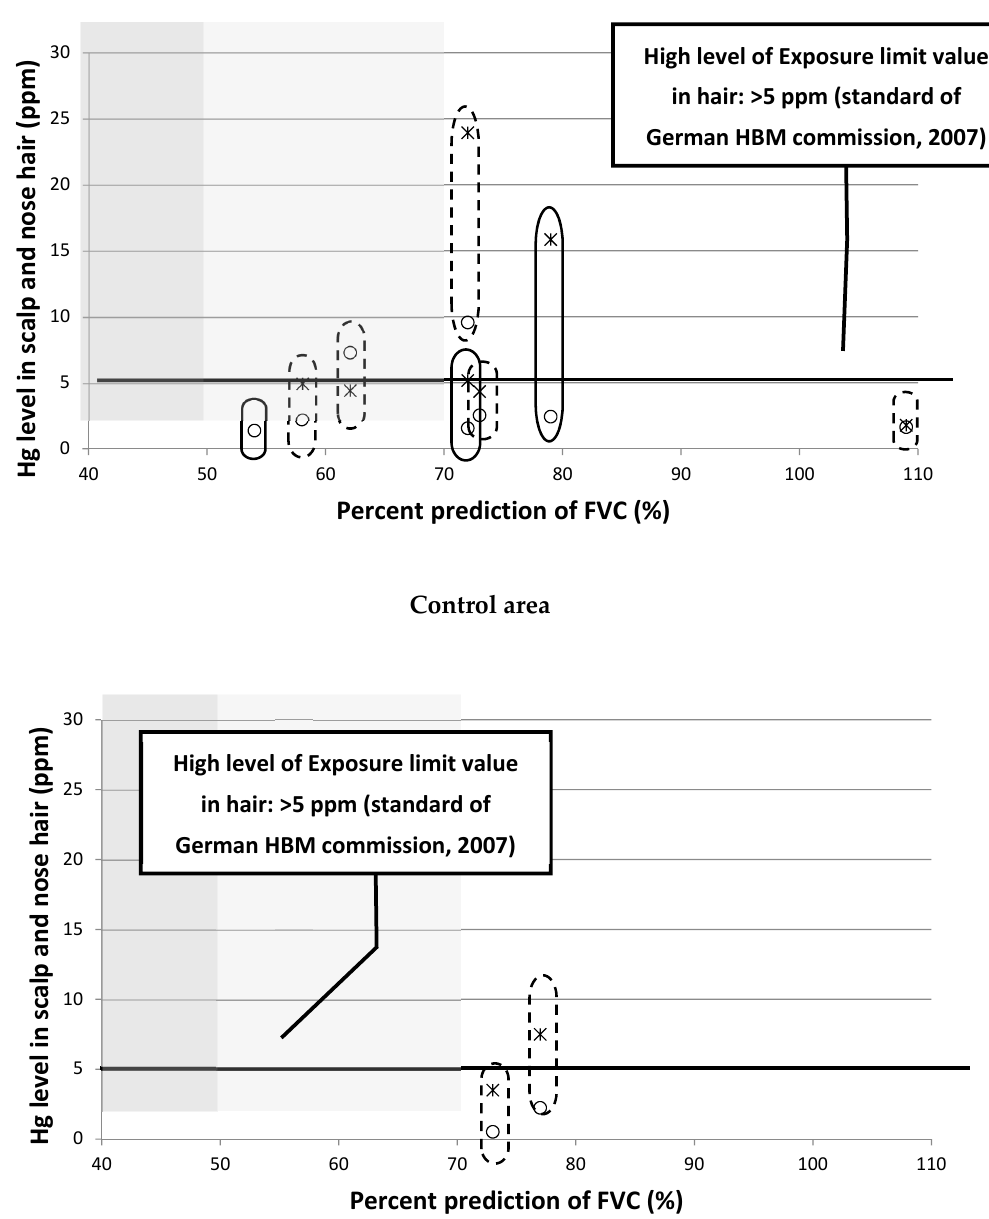
Figure 3. Level of mercury in: nose hair (PIXE); scalp hair (PIXE). Lung function by spirometry test: severe disorder; middle disorder; normal mild to no smoker moderate smoker. PIXE: particle-induced X-ray emissions.